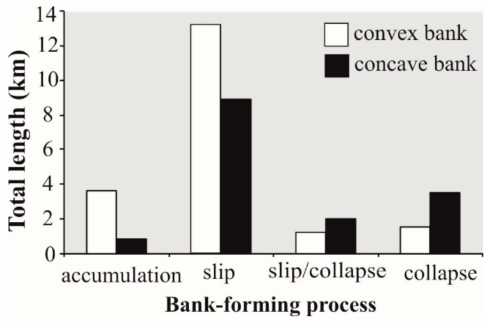
Figure 3. Bank-forming processes on the convex and concave banks of sinuous and meandering